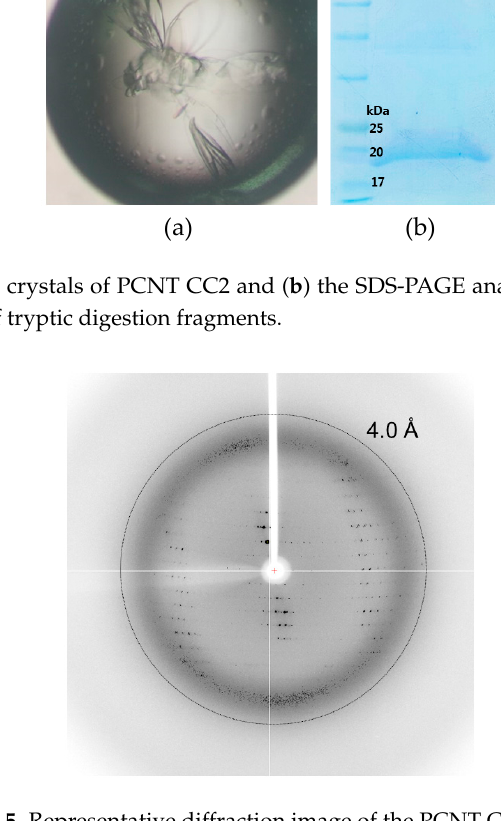
Figure 5. Representative diffraction image of the PCNT CC2 crystal.